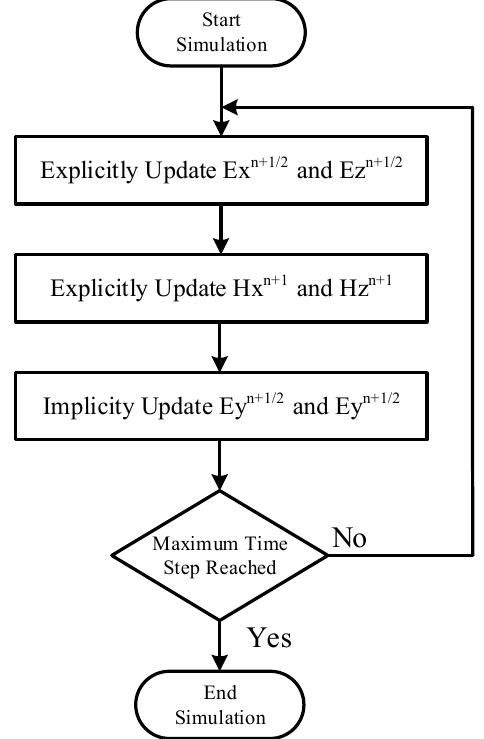
Figure 1. The block diagram of the entire update procedure. Table 1. The multiplication/division and addition/subtraction operators with explicit and implicit equations in different